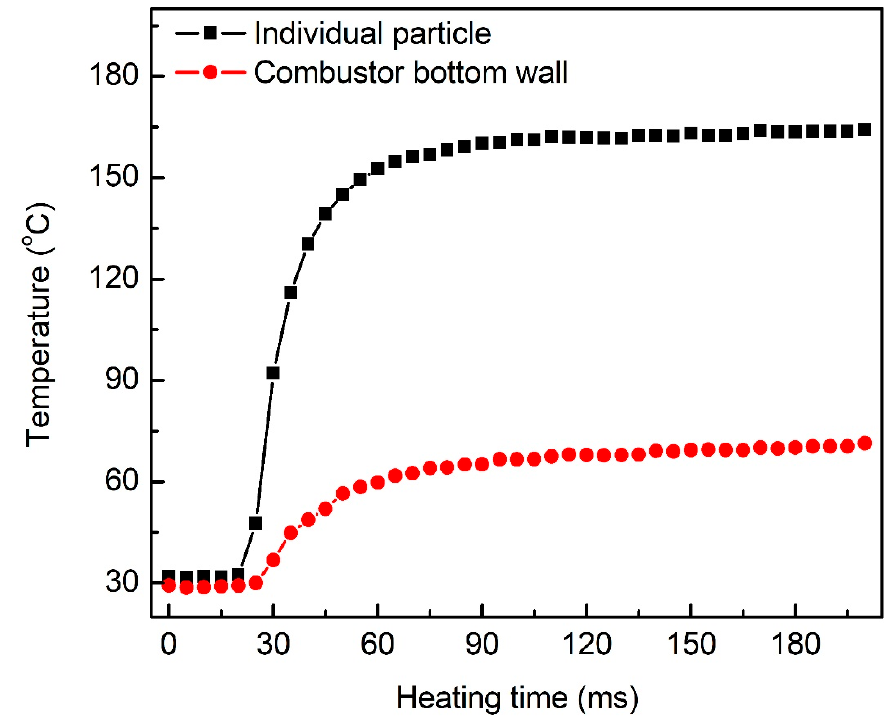
Figure 2. The temperature evolutions of an individual particle and the combustor bottom wall below the particle heated by the laser at a power density of 8.85 × 10 5 W/cm 2 .